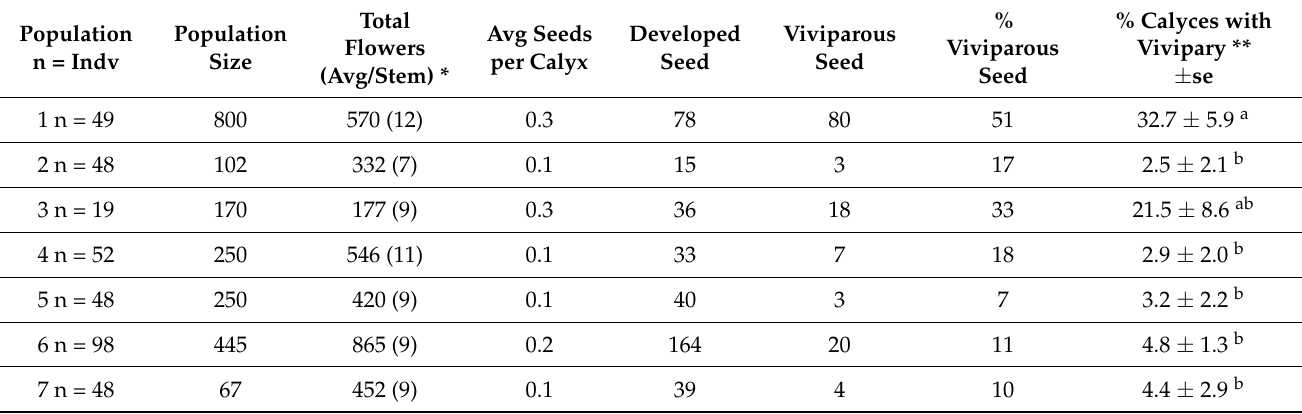
Table 1. Summary of the number of sampled individual stems, estimated population size, total flowers per population, and estimated average flowers per stem. Average number of seeds per calyx, number of developed seeds, and viviparous seeds collected per population. Percent viviparous seed is a percent of total seed set (developed seed + viviparous seed) for each population. Percent calyces per stem with at least one incidence of vivipary across sampled individuals per population.